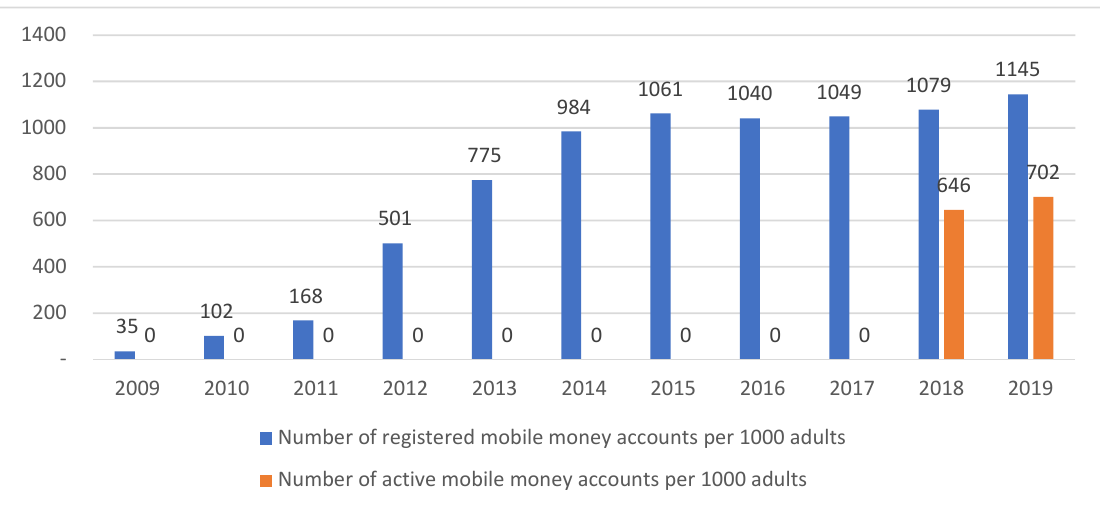
Figure 4. Registered mobile money accounts and active mobile money accounts per 1000 adults. Mobile money transactions per 1000 adults increased from about 180 in 2009 to about 120,000 in 2019. The fastest growth in the number of mobile money transactions per 1000 adults was encountered between 2017 when there were 50,000 transactions per 1000 adults and 2019 when there were about 120,000 transactions per 1000 adults. Figure 5 shows growth in mobile money transactions per 1000